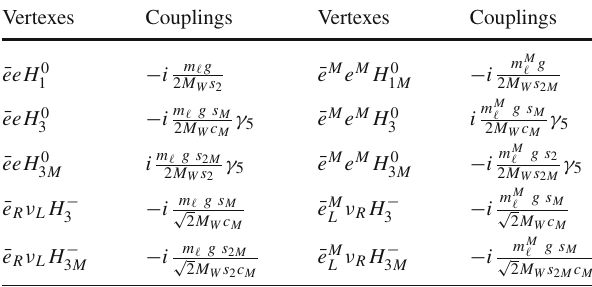
Table 1 Vertexes that contribute to the (cid:4) → (cid:4) (cid:11) γ decay rates, written in the gauge basis Vertexes Couplings Vertexes